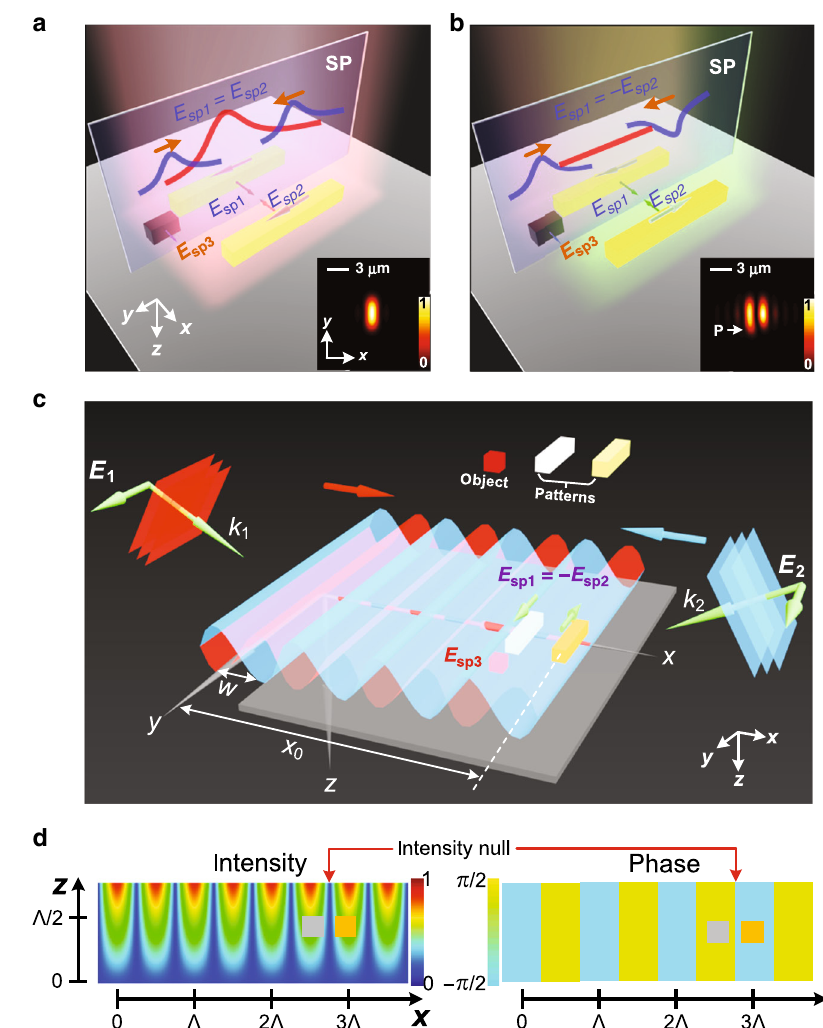
Fig. 2 Simpli fi ed schematics and experimental implementation of the proposed framework. a and b Nanostructure ensemble consisting of a pair of dielectric nanowires and an object on a substrate under a conventional and b anti-symmetric excitation modes. Each nanowire is 20 nm wide by 800 nm long by 60 nm tall. The edge-to-edge gap for the nanowires is 100 nm. The object is a short nanowire that is 20 nm wide by 100 nm long by 60 nm tall. The distance between the center of the object and symmetry plane (SP) is 30 nm. The insets at the bottom right-hand corner are the corresponding bright fi eld images. E sp1 and E sp2 denote the unperturbed electric fi eld on the SP arising from the left and right nanowires. E sp3 is the simpli fi ed form of the last three terms on the right-hand side of Eq. (1). c Generation of the anti-symmetric excitation modes at many different locations for the nanostructure ensemble along the sample using two-wave interference with inclined angles. The different colors (white and yellow) used for the pair of nanowires in c indicate that the system is excited into the anti-symmetric mode. d The intensity and phase of the standing wave versus x and z . The pair of nanowires (represented by a gray and a yellow box) need to be positioned symmetrically with respect to an intensity null such that the anti-symmetric condition E sp1 = − E sp2 holds. The position of the selected intensity null is pointed out by red arrows in d